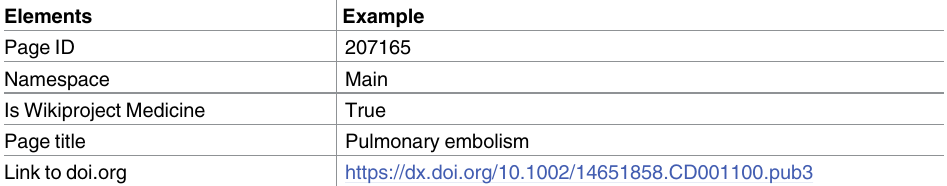
Table 2. Data elements extractedfor each English-language Wikipedia page that included at least one